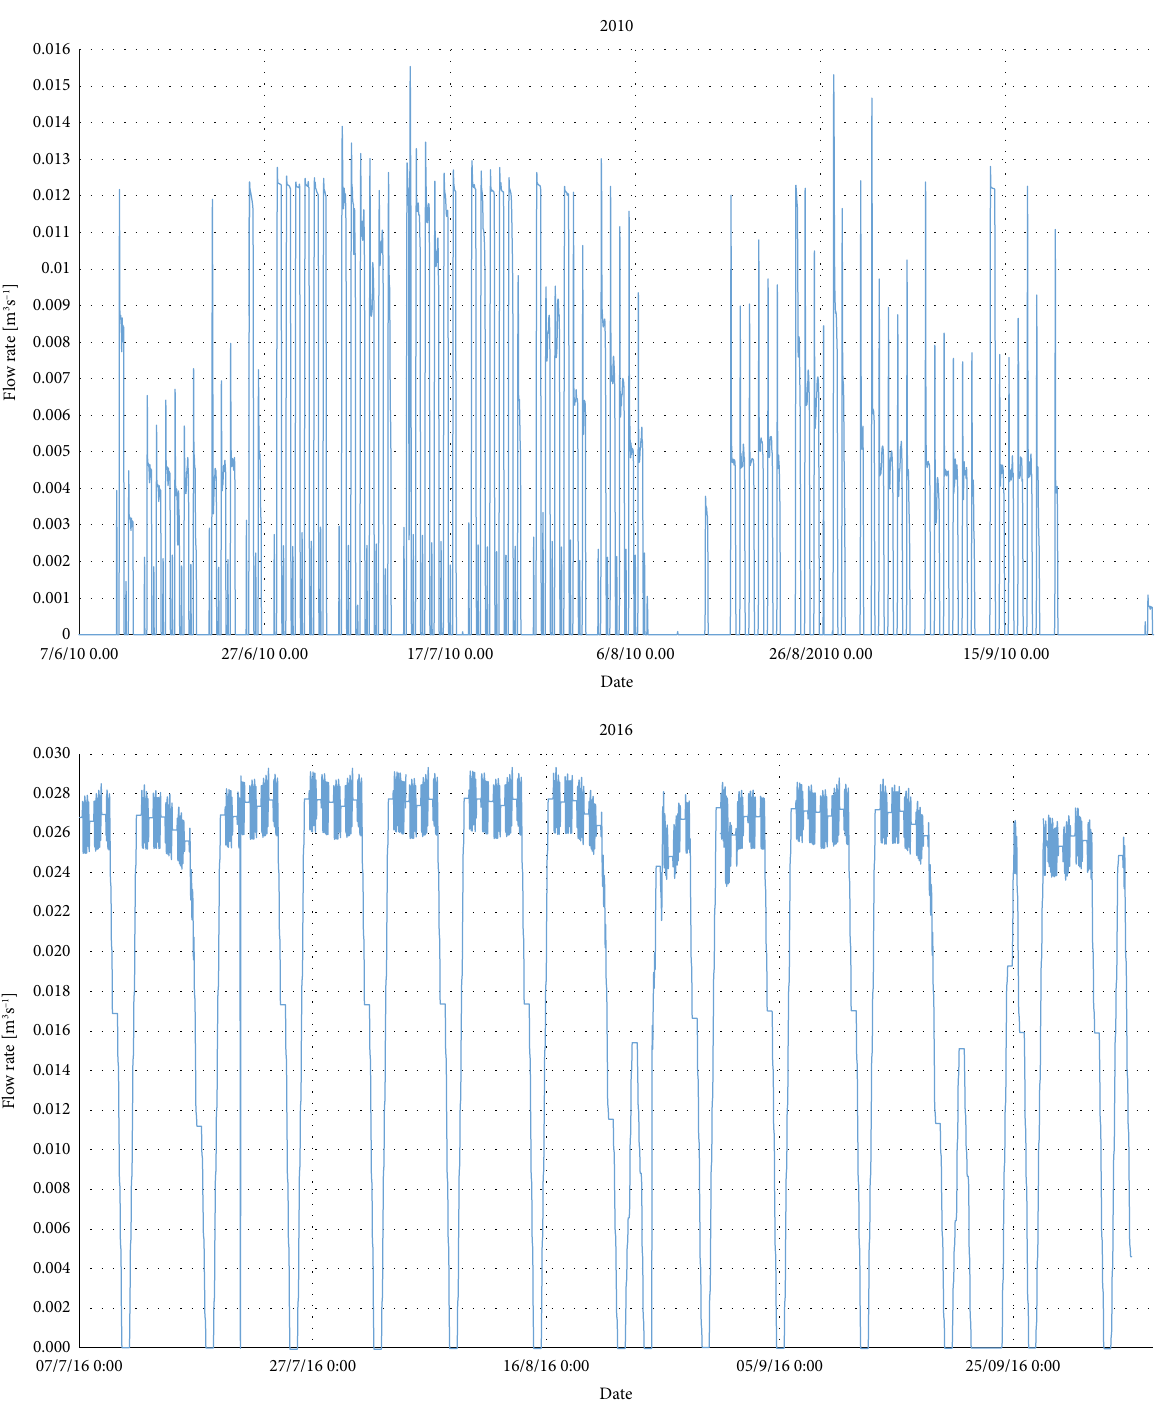
Figure 5: Recorded hourly fl ow rate data [m 3 s -1 ] for each monitored season (2010 and 2016). Table 3: Simulated and analytically estimated thermal-load values [KW] for each monitored season 2010 (128 days) and 2016 (90 days). Simulation Analytical